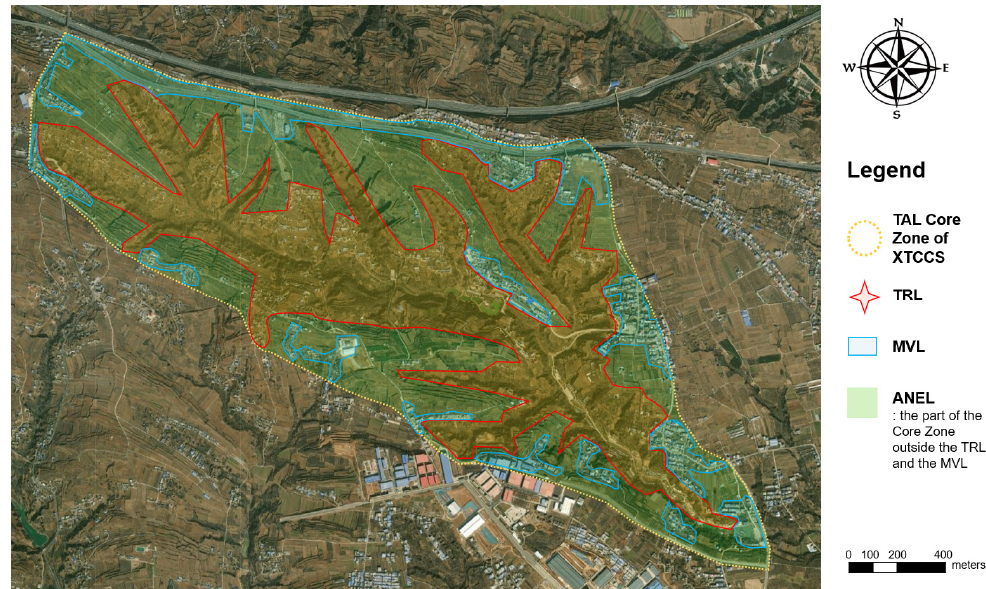
Figure 4. Zoning map of the TAL Core Zone of XTCCS in 2020.